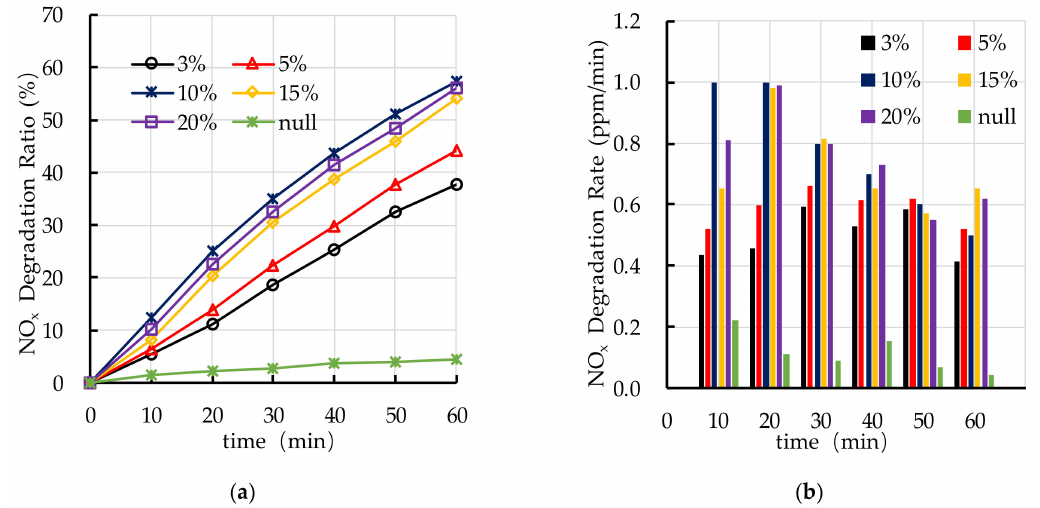
Figure 13. E ff ect of TiO 2 dosage on photocatalytic degradation of NO x : ( a ) NO x degradation ratio; ( b ) NO x degradation rate.